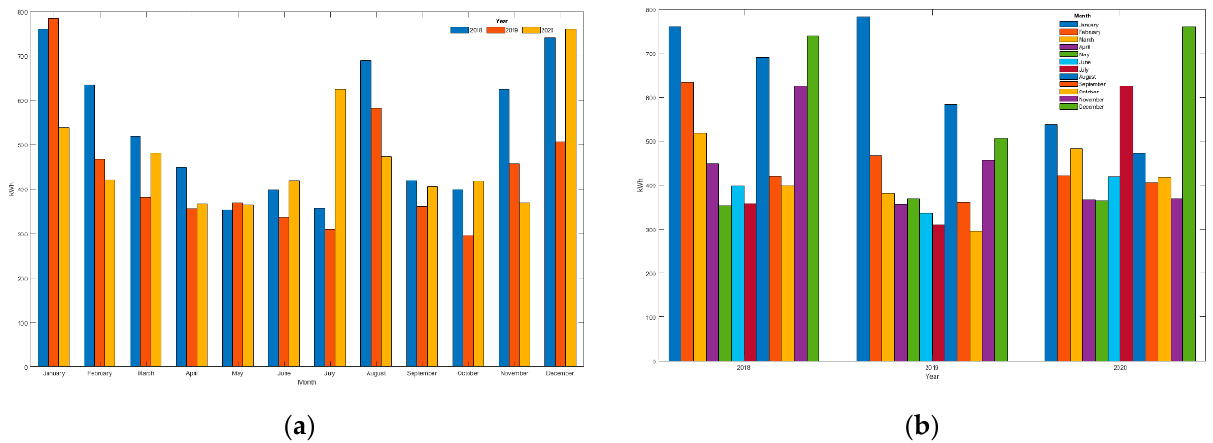
Figure 23. ( a ) For each month, the comparison of electricity consumed (kWh) is sorted by year. ( b ) For each year, a comparison of electrical energy consumed (kWh) is sorted by month. Table 8. Monthly bill: previous period P0; first period P1 (yellow); second period P2 (green); third period P3 (blue).